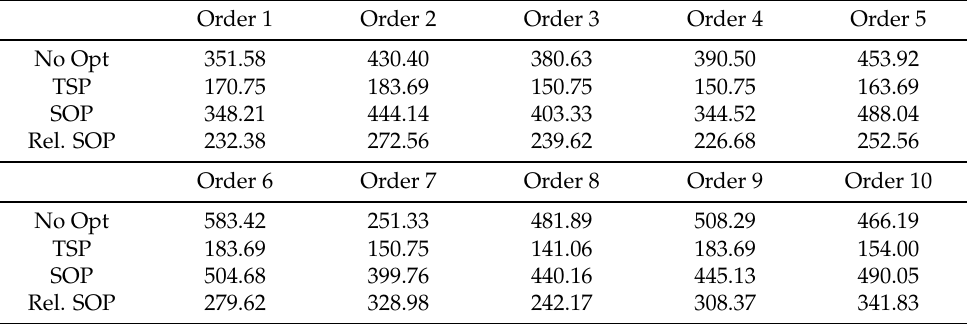
Figure 3. Simulated travel times with different routing strategies implemented for 10 BOPS orders. Table 6. Comparison between simulated travel times with different routing strategies implemented for 10 BOPS